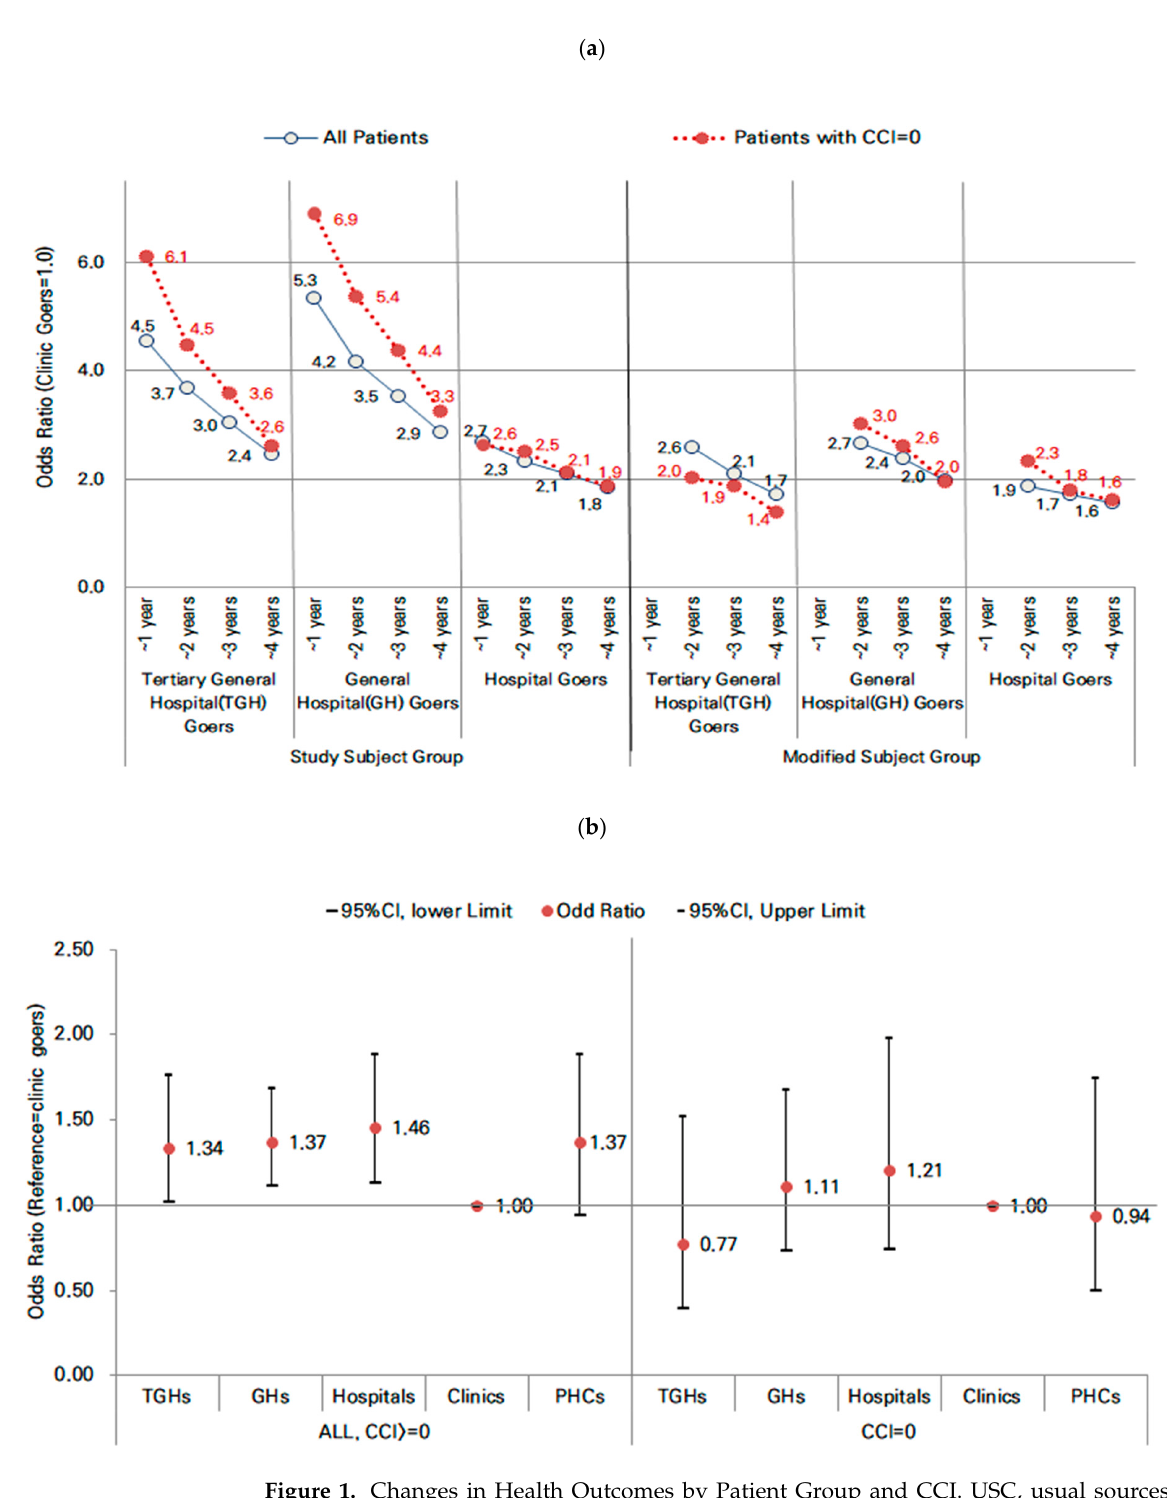
Figure 1. Changes in Health Outcomes by Patient Group and CCI. USC, usual sources of care (Reference = clinics; patients who frequented clinics as their USC): reference to Tables 2 and 3. Odds Ratio of Diabetes-related Hospitalization ( a ), Odds Ratio of All-cause Death after 3 years since the diagnosis ( b ).